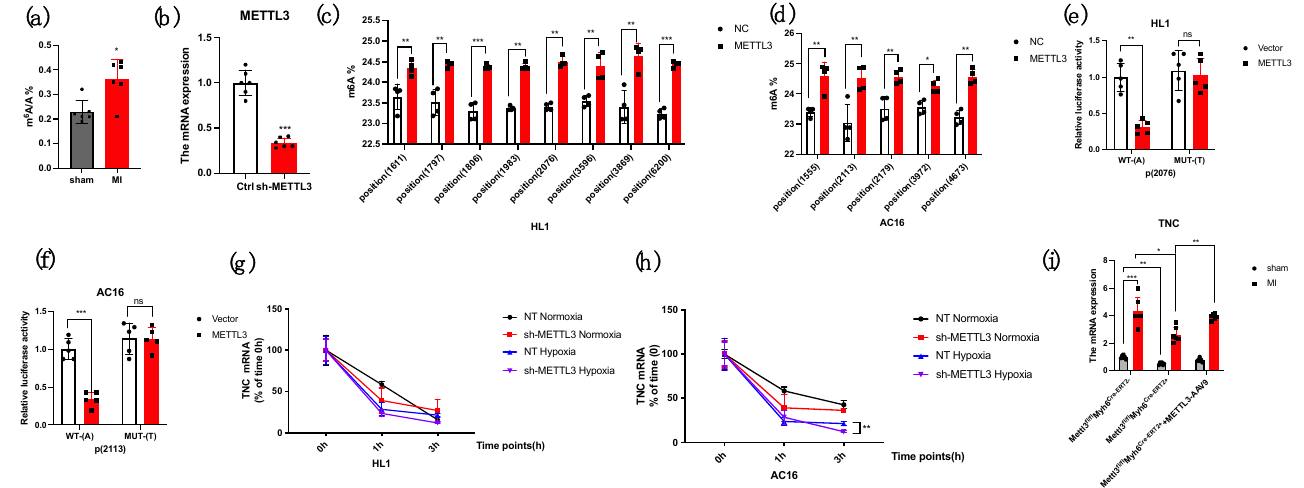
Figure 5. METTL3 regulates the m 6 A process of TNC mRNA. ( a ) LC-MS/MS was used to analyze the m 6 A/A level ( n = 6); ( b ) the METTL3 mRNA level after shRNA treatment ( n = 6); ( c ) SMRAP